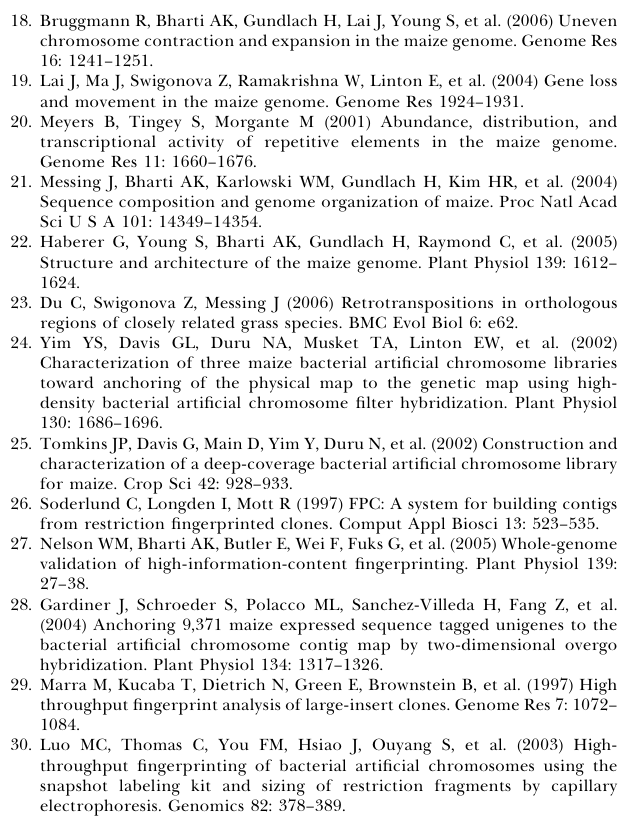
Figure S1. Correlation between Gene Distribution and Genetic Recombination The distribution of EST-derived overgo markers and genetic markers was plotted against maize chr1. The overgos, which hybridized to at least two BAC clones in each contig and hit fewer than ten contigs, were counted for the plot. The overgos and genetic markers were counted as a total in each Mb region. Figure S2. Overall Block View of Maize–Rice Synteny (A) General view of maize–rice synteny alignment is presented. This is the block view generated from dotplot analysis in Figure 1. Rice chromosomes are in the middle of each synteny block as gray vertical bars, and rice centromeres are shown in red. Maize chromosomes are colored as shown in the horizontal color key. (B) Physical synteny map of rice chr2 with maize chromosomal regions is presented. Each maize physical block is indicated by chromosome number and FPC contig numbers. When clicked in our interactive website (http://www.agcol.arizona.edu/symap), an individ- ual block view with rice alignment or a comparative block view like Figure 2 will pop up. Table S1. Major Release of the Maize Physical Map Table S2. Summary of the Maize Genetic Map Table S3. Distribution of Different Marker Types among Chromo- somes Found at doi:10.1371/journal.pgen.0030123.st003 (16 KB XLS).